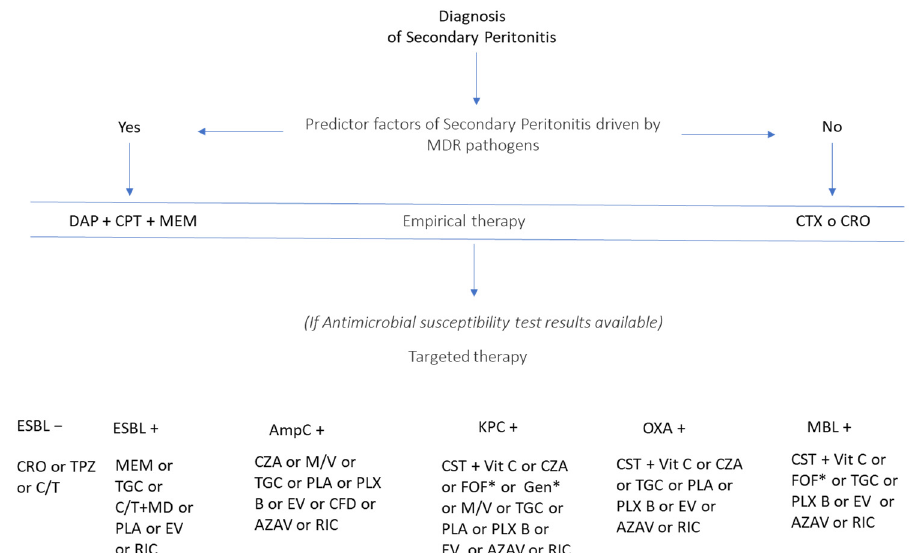
Figure 7. Pharmacological options to treat secondary peritonitis by